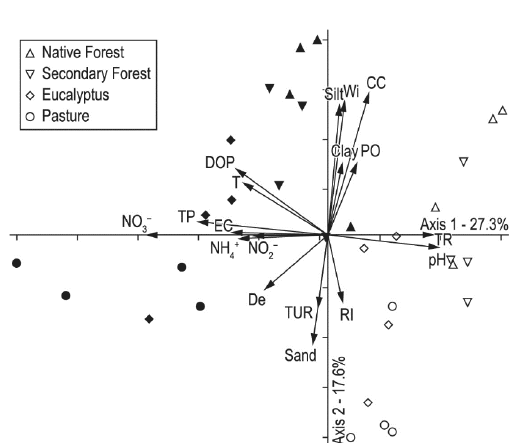
Figure 3. Principal components analysis (PCA) plot of the abiotic variables measured along the upper-middle course of the Paraitinga River, considering four different riparian conditions for the dry and rainy seasons. Environmental variables are indicated by